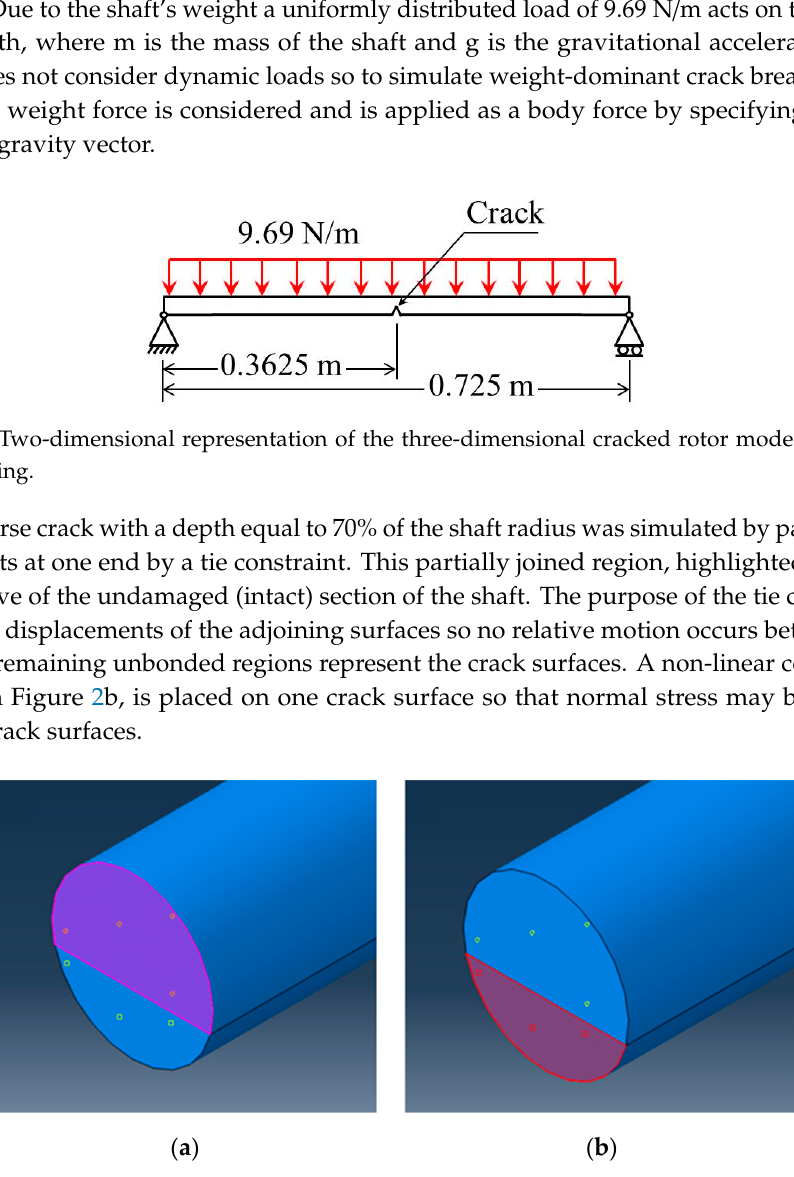
Figure 2. Transverse slice taken at crack location highlighting the ( a ) undamaged area and ( b ) fractured area via the shaded regions, for which the crack depth was set to 70% of the shaft radius.